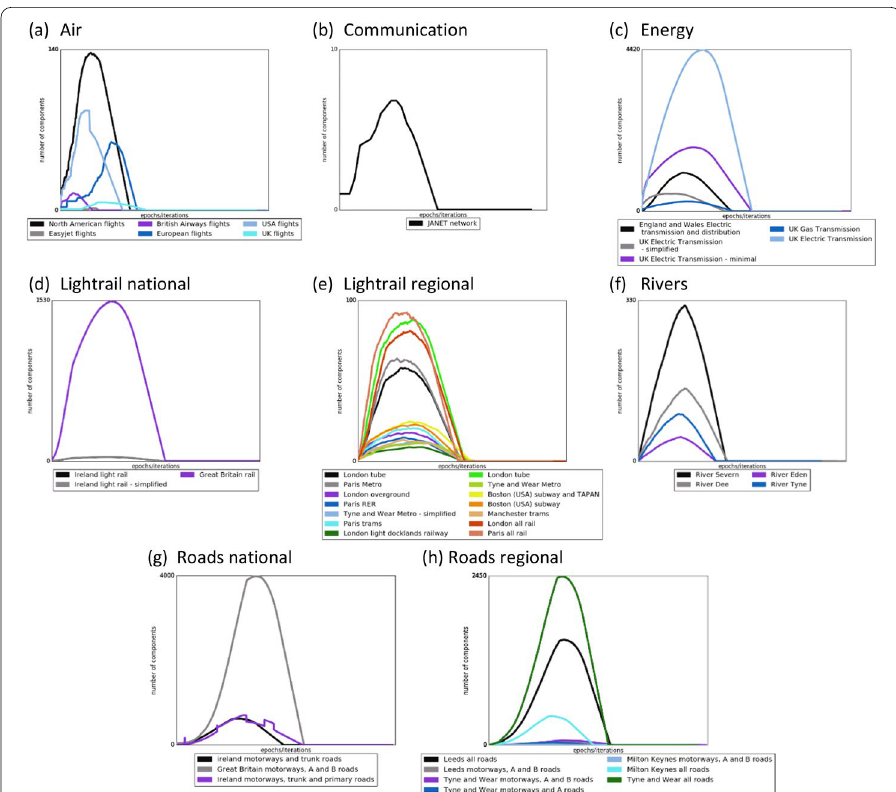
Fig. 11 Failure behaviour of the infrastructure networks under the degree failure method. The y-axis shows the number of components and the x-axis shows the % of nodes removed from the graph, with a more robust network showing a smaller peak and towards the left of the